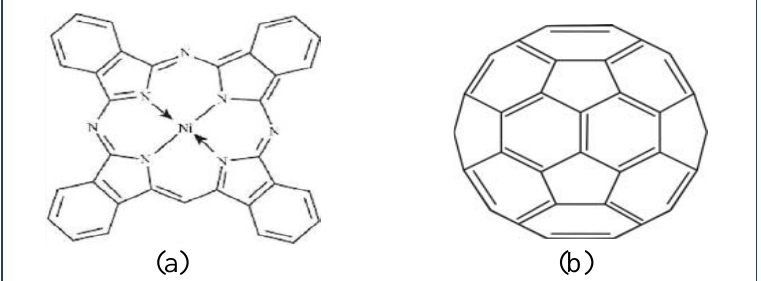
Fig. 1: The molecular structure of (a) NiPc and (b) C